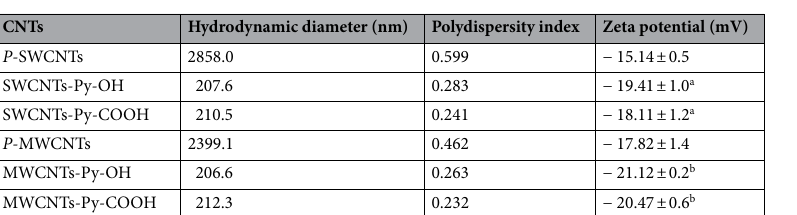
Table 1. Hydrodynamic diameter and zeta potential values for the pristine CNTs and our f -CNTs. All experiments were conducted in triplicate. One-way ANOVA test was used to compare the means. a P value < 0.05 comapre to the P -SWCNTs. b P value < 0.05 comapre to the P -MWCNTs.